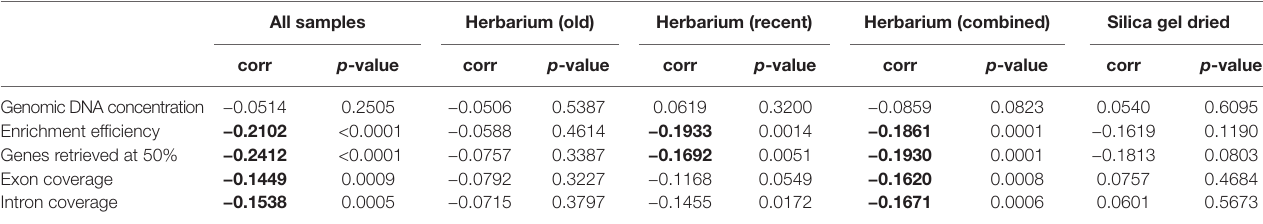
TABLE 2 | Correlations between sample age and genomic DNA concentration (ng/µl), enrichment efficiency (mapped/total reads), genes retrieved above 50% of target length, and mean exon and intron coverage (X), grouped by material source. All samples